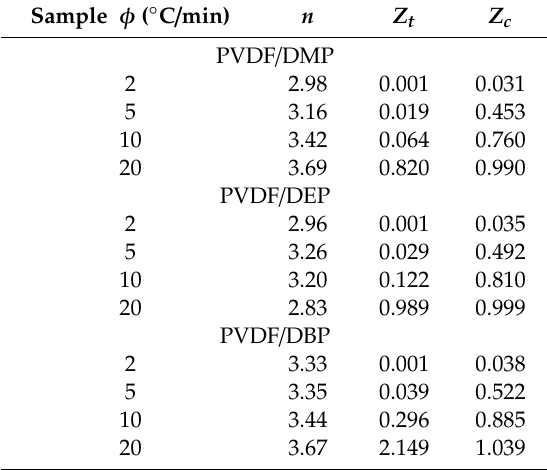
Table 3. Kinetic parameters of PVDF / dialkyl phthalate blends from the modified Avrami